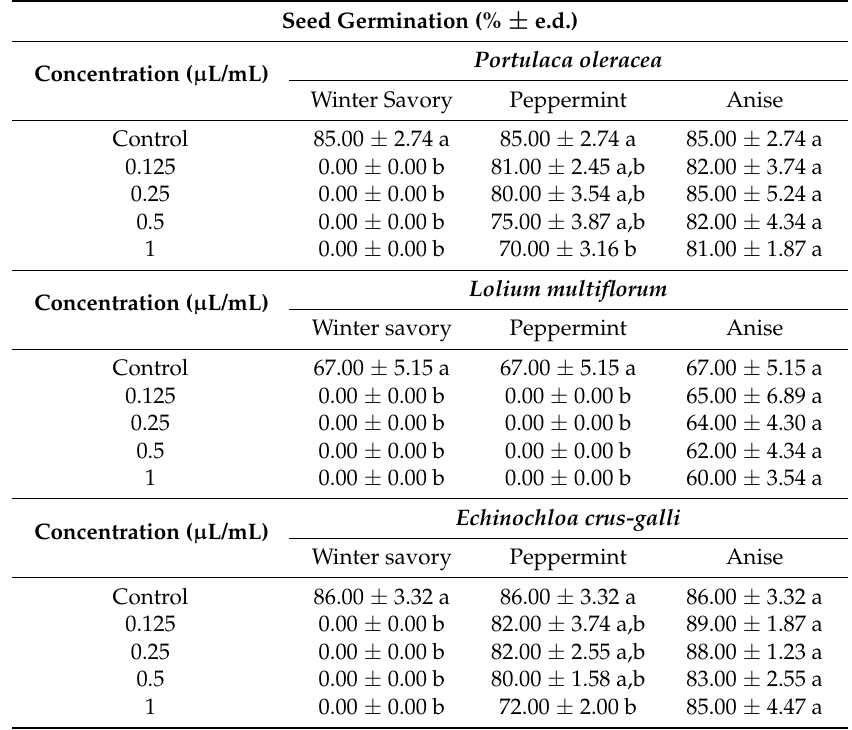
Table 2. In vitro effects of peppermint, anise, and winter savory essential oils against Portulaca oleracea , Lolium multiflorum , and Echinochloa crus-galli seed germination.